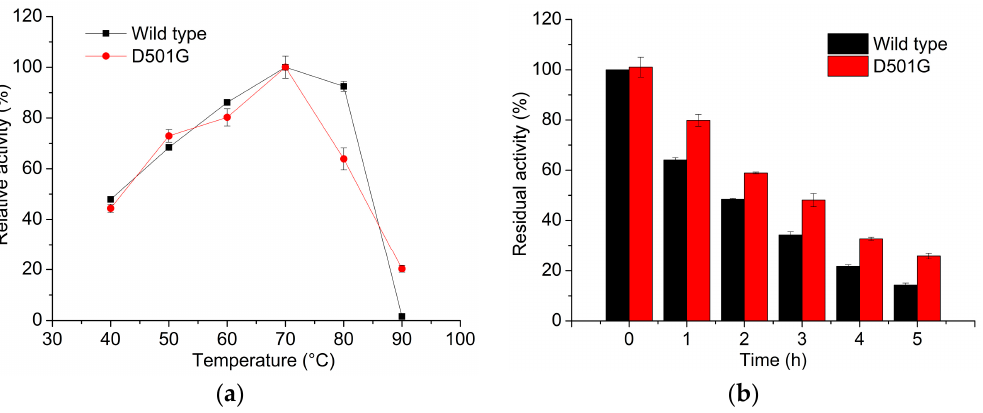
Figure 3. Effect of temperature on activity ( a ) and stability ( b ) of the wild ‐ type and D501G. ( a ) Laccase activity was measured with ABTS as a substrate; ( b ) the stability was tested at 70 °C. Error bars represent the standard deviation of three replicates. Table 1. Catalytic parameters of the purified wild ‐ type and mutant laccases.